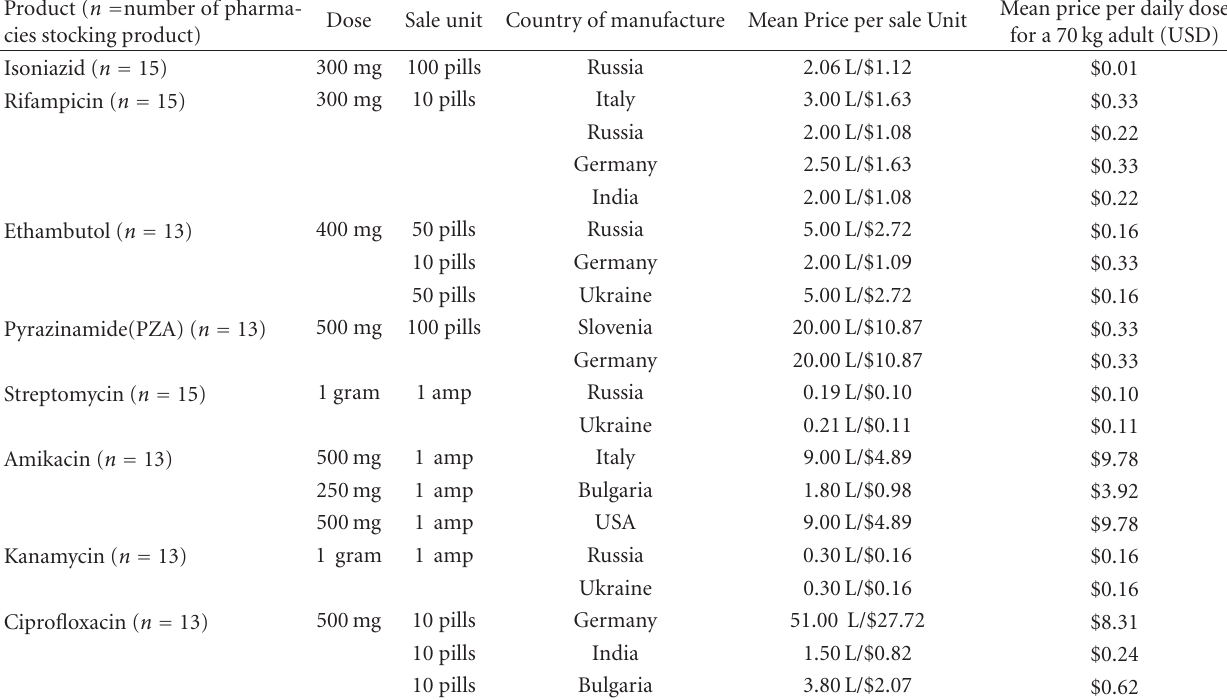
Table 1: Availability of Antituberculosis Antibiotics at 15 Pharmacies in Tblisi, Georgia Over the Counter without a Prescription. Product ( n = number of